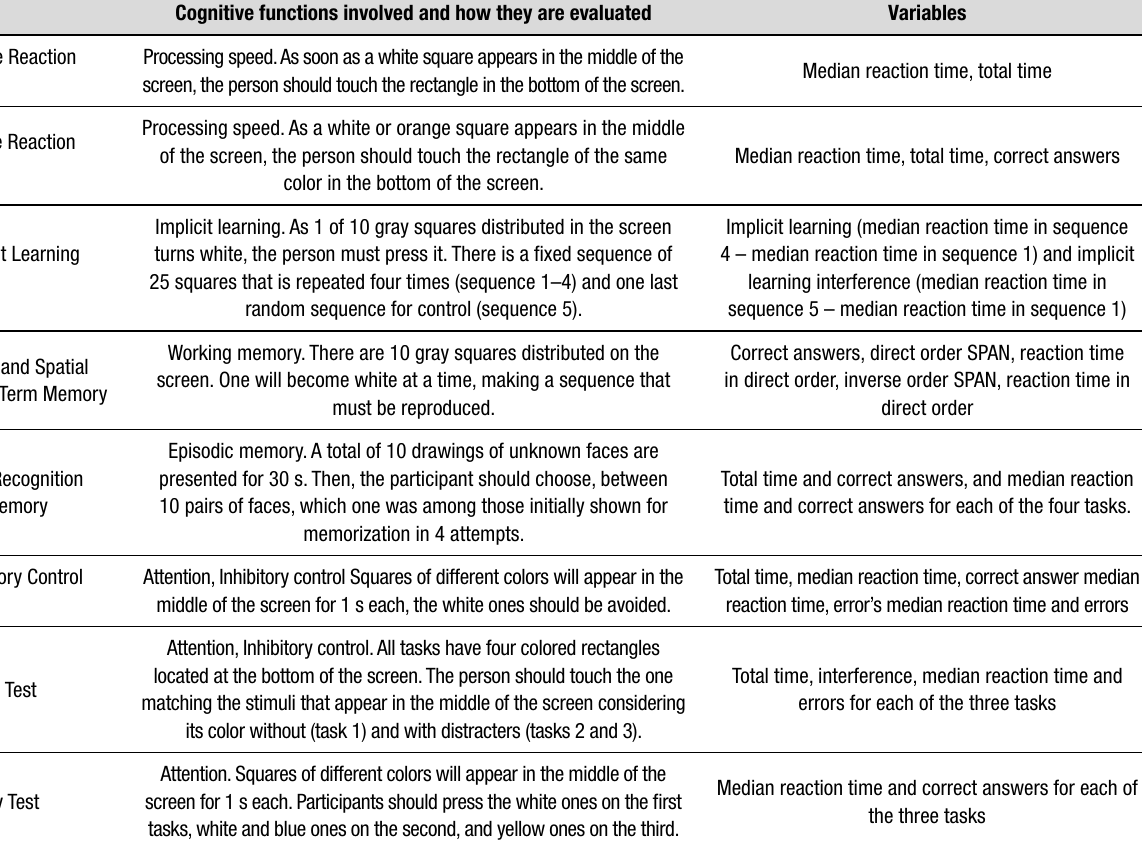
Table 1. CompCog test’s variables.